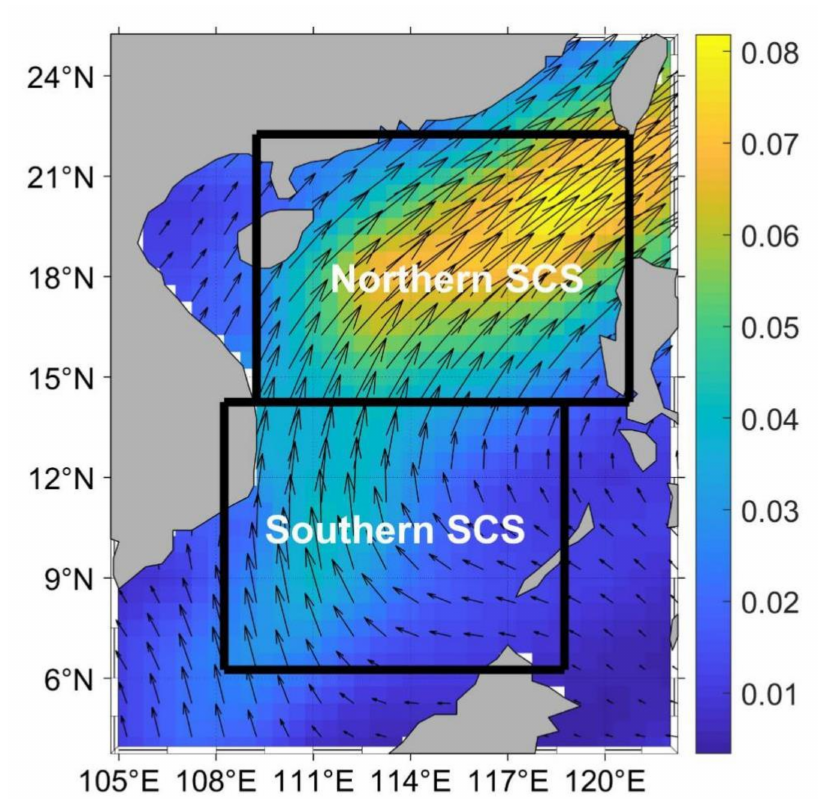
Figure 8. The spatial pattern of the first EOF mode of wind stress anomalies over SCS in the boreal winter. Color bar represents the magnitude of wind stress anomalies (in N /